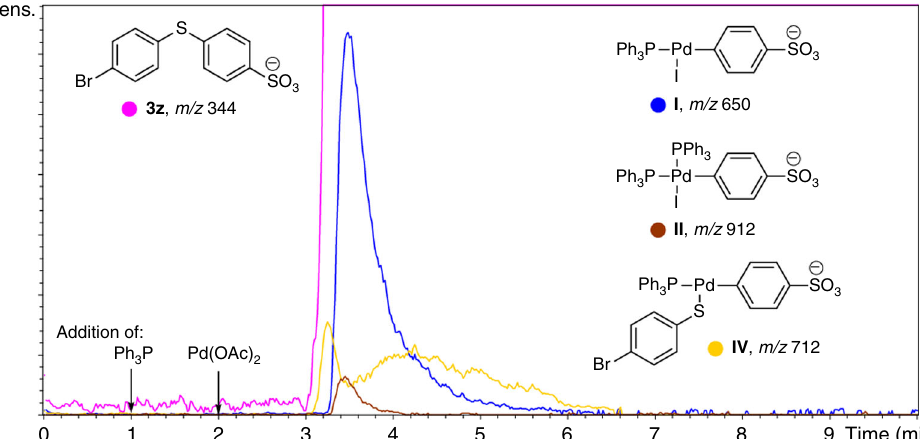
Fig. 6 ESI-MS study in the negative ion mode. Intermediate ions detected during on-line monitoring of the reaction between 4-iodobenzenesulpfonic